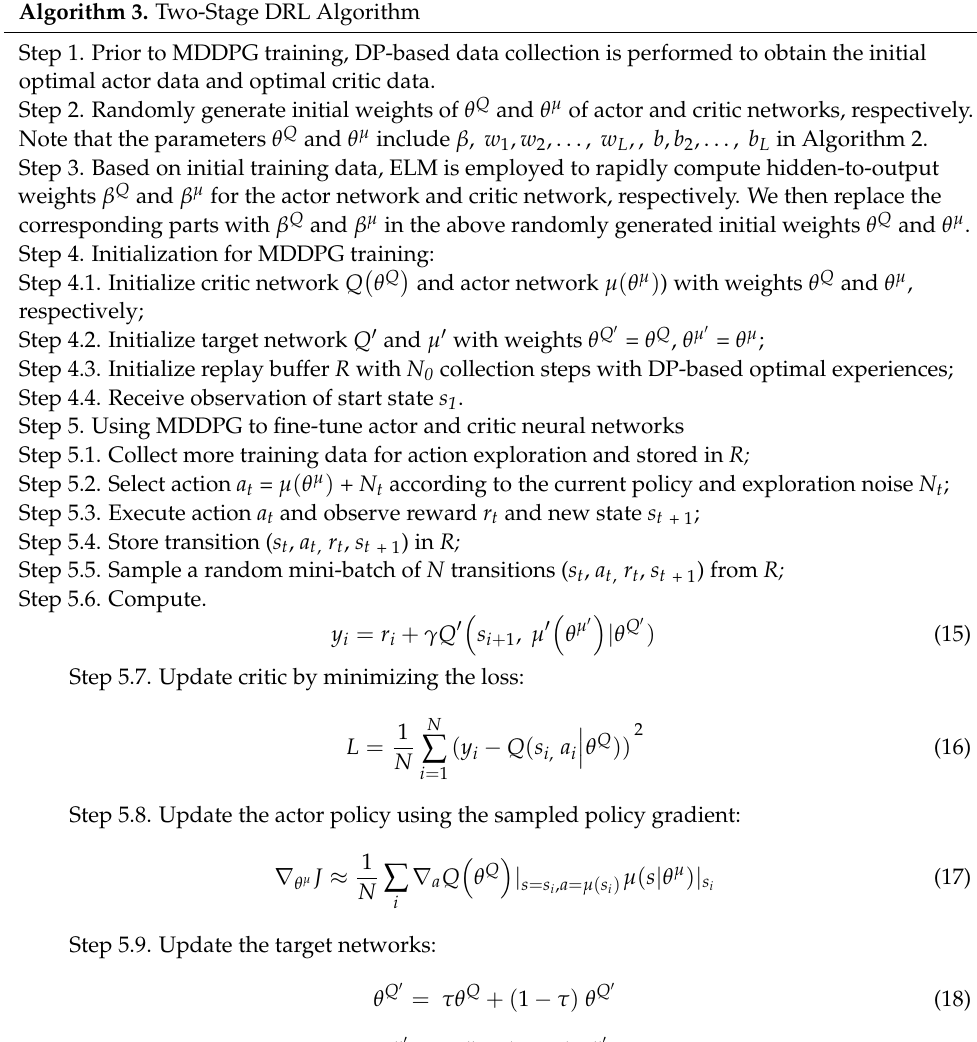
Algorithm 3. Two-Stage DRL